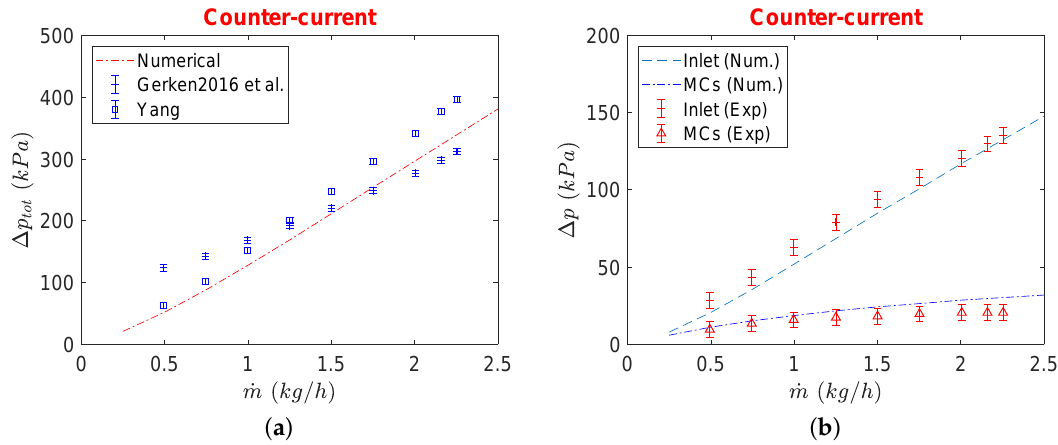
Figure 8. Comparison between experimental and numerical total pressure drop of µ Hx ( a ), and in the inlet and MCs only ( b